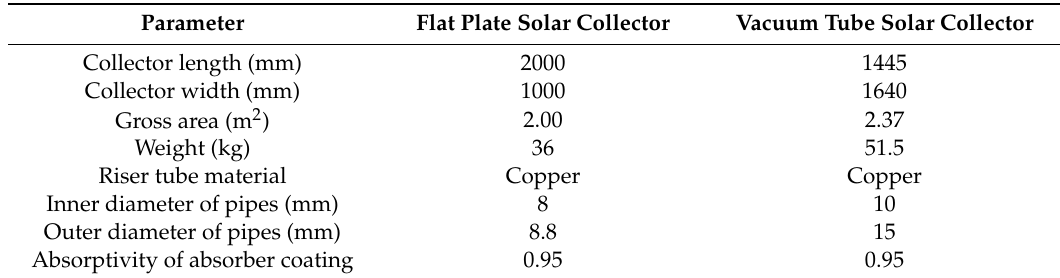
Table 2. Specifications of the flat plate and vacuum tube solar